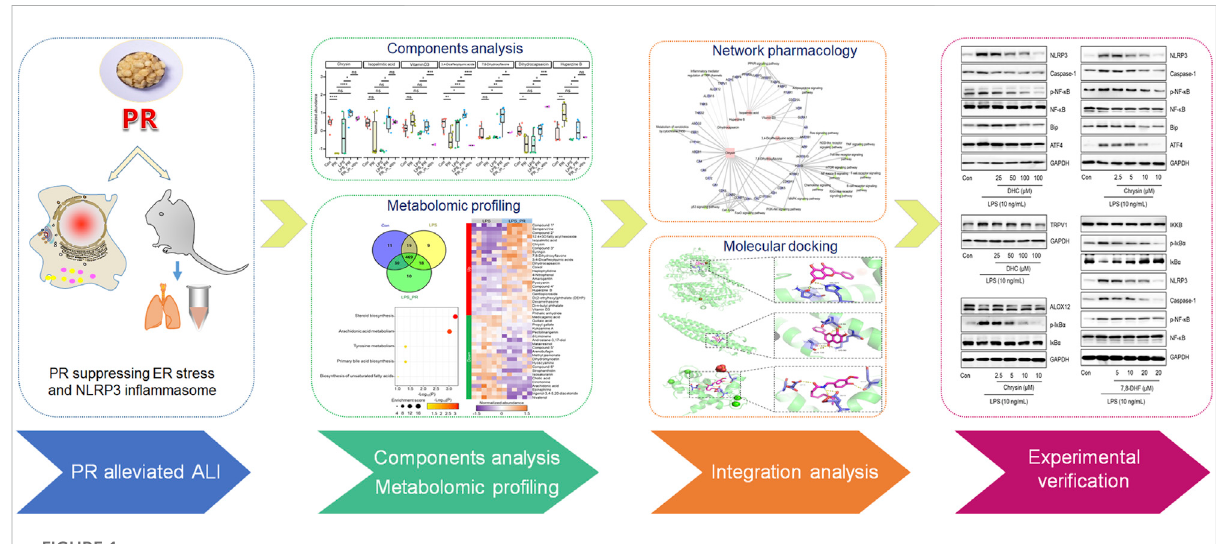
FIGURE 1 Flowchart of the research process. PR alleviates the damage caused by LPS, and its active ingredients were explored by metabolomics and validated in vitro